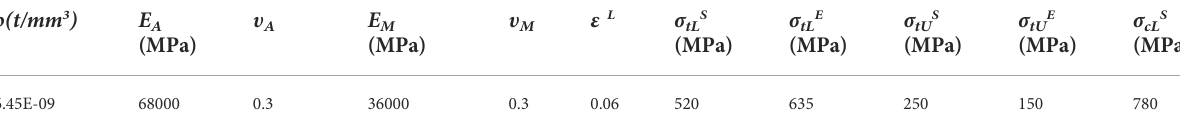
TABLE 1 Parameter values of superelastic model for nitinol (He et al., 2022). ρ (t/mm 3